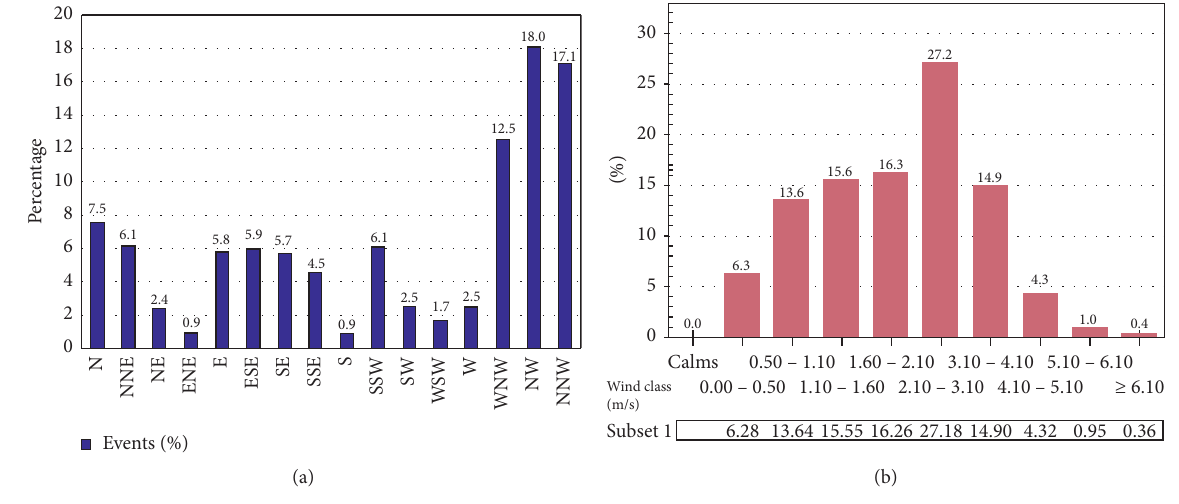
Figure 3: Distribution of (a) wind directions and (b) speed class. Table 5: Calculated dose results using GASPAR.